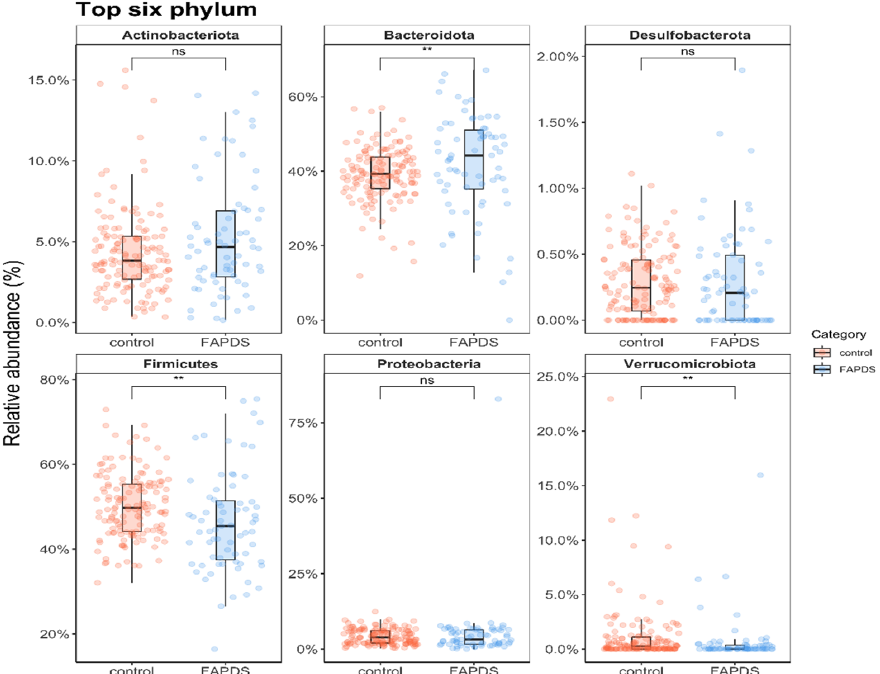
Figure 1. The relative abundances of the six identified phyla between the FAPDs and the control groups ( p -value of <0.05 was con- sidered significant). ** denotes significance, while ns refers to non-significant.